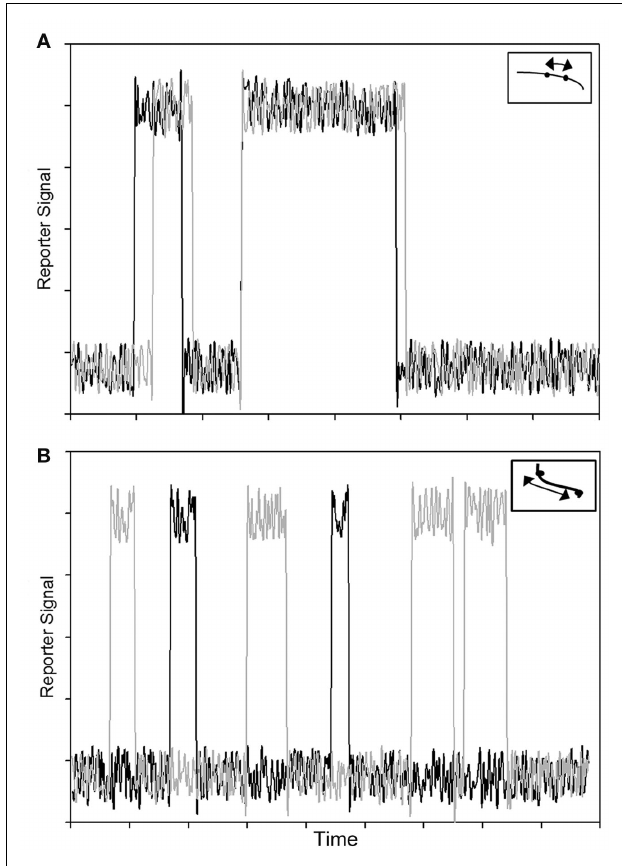
FIGURE 2 | Overlay of signals (traces in black and gray) from two reporter probes corresponding to two regulatory subunits on a single thin filament. (A) Correlated signals from two reporter probes separated by a short distance demonstrate predicted result for cooperative interactions along a thin filament. (B) Uncorrelated signals from two reporter probes separated by a longer distance.The insets depict single thin filaments where the dots correspond to reporter probes on individual regulatory subunits; arrows represent distances between the reporter probes.